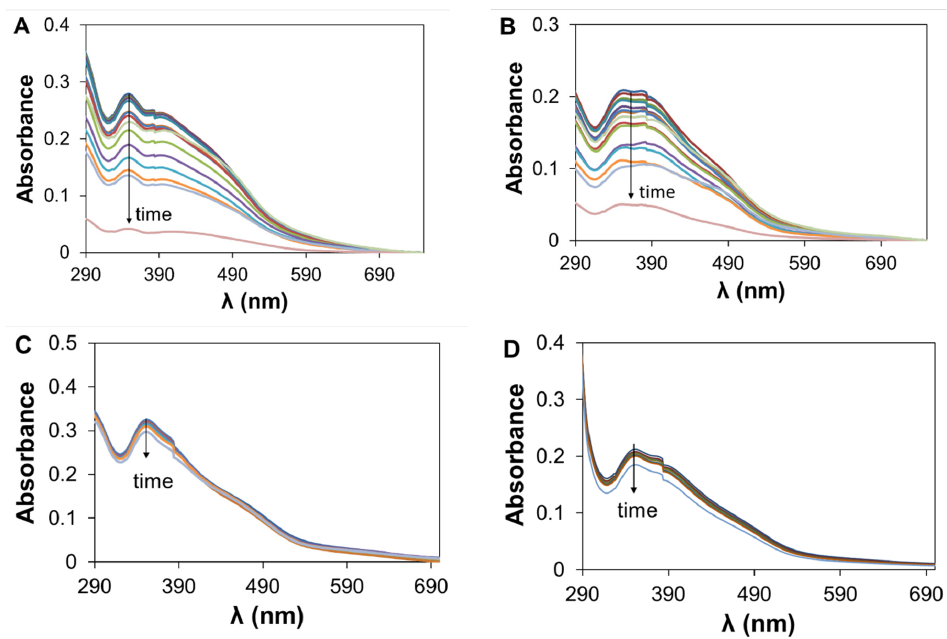
Figure 3. Aqueous stability tests with Cu(II) complexes 1:1 ( A , C ) and 2:1 ( B , D ) in the absence ( A , B ) and in the presence of equimolar amounts of BSA ( C , D ). The complexes’ concentration was ca. 25 μ M with <1% DMSO and the measurements were done up to 24 h.